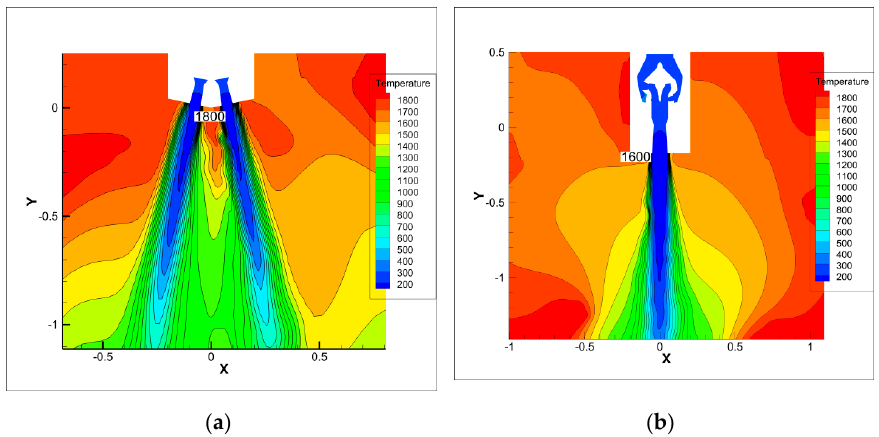
Figure 10. Comparison of interaction behavior between Laval and cyclone oxygen lances under dif- ferent parameters: ( a ) comparison of interaction behavior between Laval and cyclone oxygen lances (lance height 1550 mm, operation pressure 1.0 Mpa); ( b ) comparison of interaction behavior between Laval and cyclone oxygen lances (lance height 1100 mm, operation pressure 1.0 Mpa); ( c ) compari- son of interaction behavior between Laval and cyclone oxygen lances (lance height 1100 mm, oper- ation pressure 0.8 Mpa).